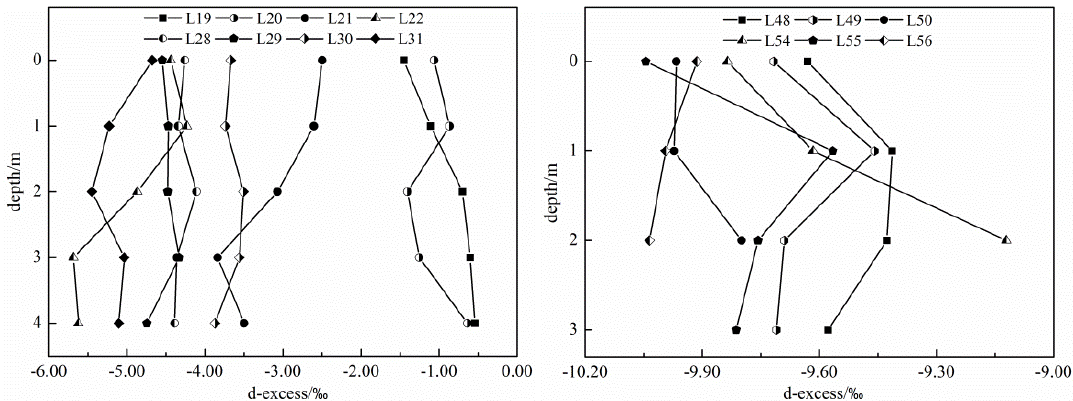
Figure 8. Variations of d-excess along vertical profiles taken in August 2014 ( left ) and April ( right ) 2015.